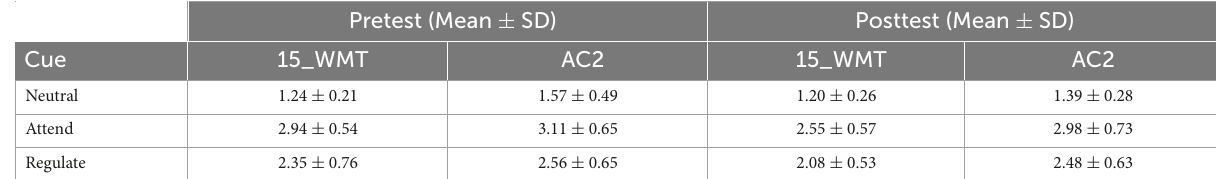
TABLE 2 The emotional reports for the Neutral, Attend, and Regulate conditions in Experiment